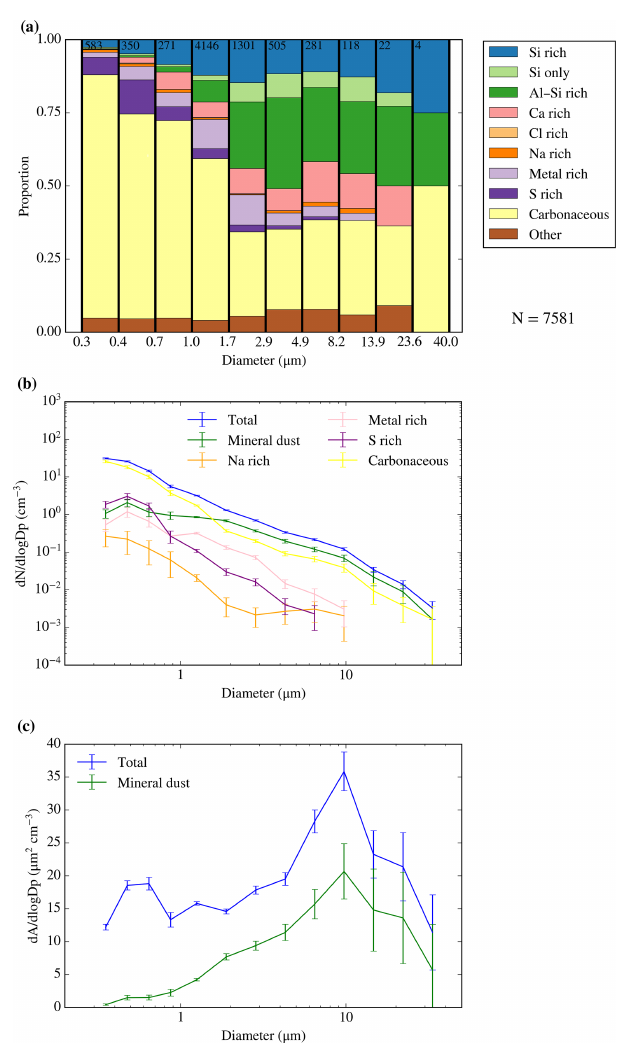
Figure 10. Size-segregated compositional and morphological anal- ysis of a sample collected close to London (SE England) on 19 July 2017 from 15:20 to 15:52UTC by the lower line with the bypass open, sampling a total of 953L at 350m altitude. (a) Frac- tion of particles corresponding to each compositional category (de- scribed in the Appendix B) for each size. The number of particles per bin can be seen in the top of the figure. (b) Number size distribu- tion for each composition. Cl-rich particles were not included since only two particles in this category were found. The errors have been calculated from the Poisson counting statistics (applying it to both the size distribution and the compositional measurements). (c) Sur- face area of both all the detected aerosol particles and the ones whose composition was consistent with mineral dust. Errors have been calculated in the same way as before. By integrating the green curve in (c) we obtained the total surface area of mineral dust in the sample (19.1µm 2 cm − 3